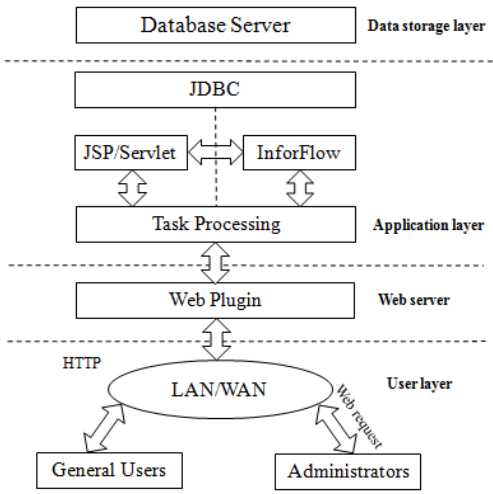
Figure 6. Overall business framework of TPCP spectral library